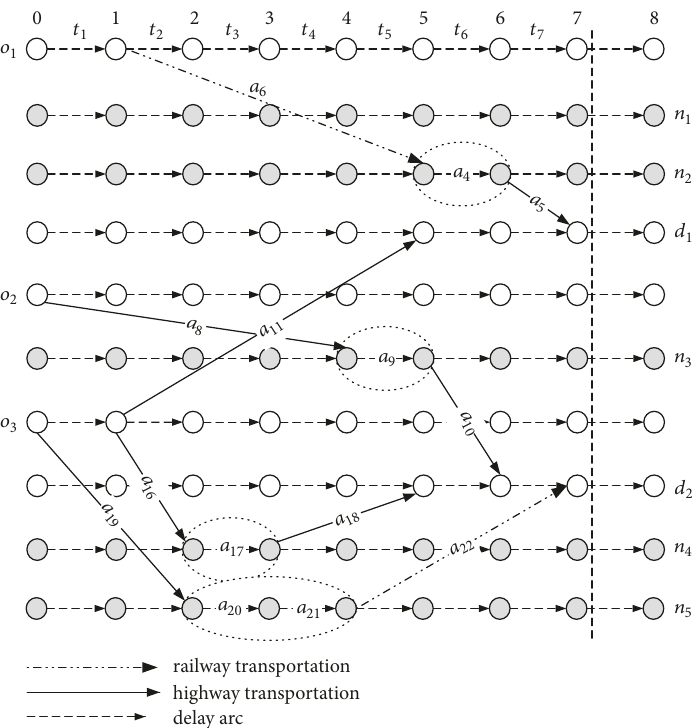
Figure 4: The optimized time-space network of the empty pallet